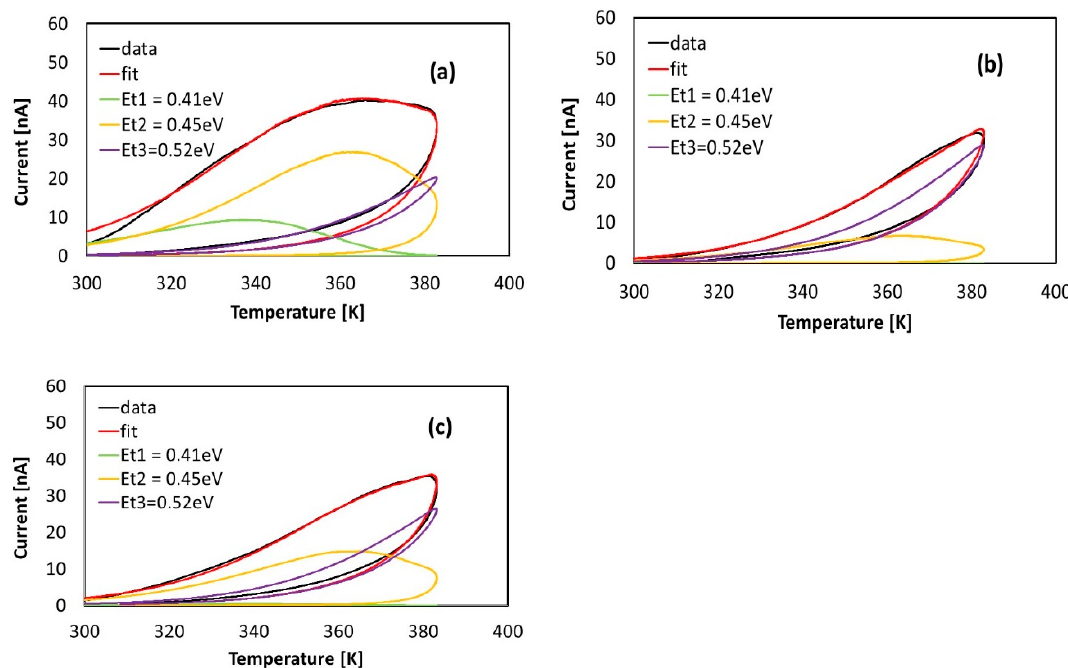
Figure 5. Thermally stimulated currents, TSC peaks calculated using Equation (8) and best fit obtained by the sum of data shown in Figure 3 measured after: ( a ) ambient storage; ( b ) and ( c ) priming with LED 400 nm T i = 290 K and t fill = 230 s and 640 s, V b = 5 V and heating cooling rate β = 0.08 K/s.